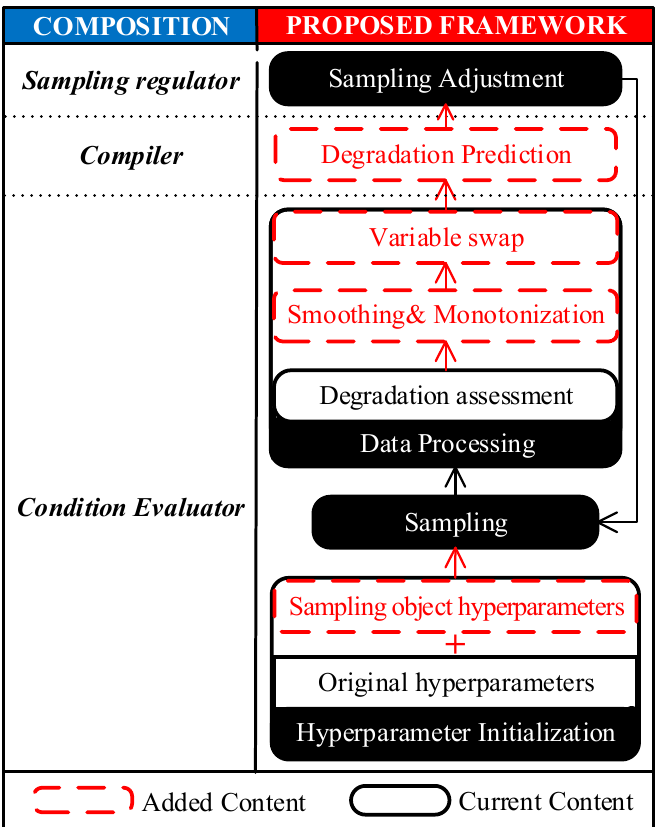
Figure 5. A diagrammatic sketch of the proposed framework.